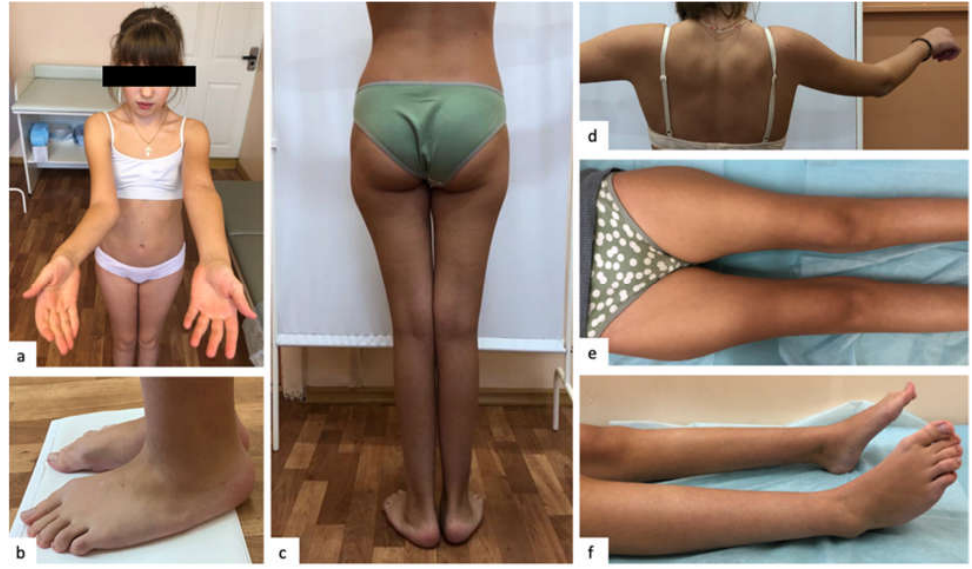
Figure 1. Patient’s general appearance at the age of 10 and 12 years. ( a , d ) The contracture of the right elbow joint; ( b ) Plano-valgus deformity of the feet; ( c , e , f ) leg muscles hypotrophy. Orthopedic examination revealed flexion contracture in the right elbow and excessive pronation of both forearms along with hypermobility in the interphalangeal joints; the right upper limb was shorter than the left due to a flexion contracture. Supination of the forearms was limited and painful. Ulnar deviation (ulnar clubhand) on both sides was revealed. There was no remarkable spinal deformity, but the range of flexion-extension and rotational movements of the spine was mildly limited. The axis of the lower extremities was moderately valgus, the patellas were centered and relatively high positioned (patella alta) and the rotation of the hip joints was moderately painful in extreme positions.